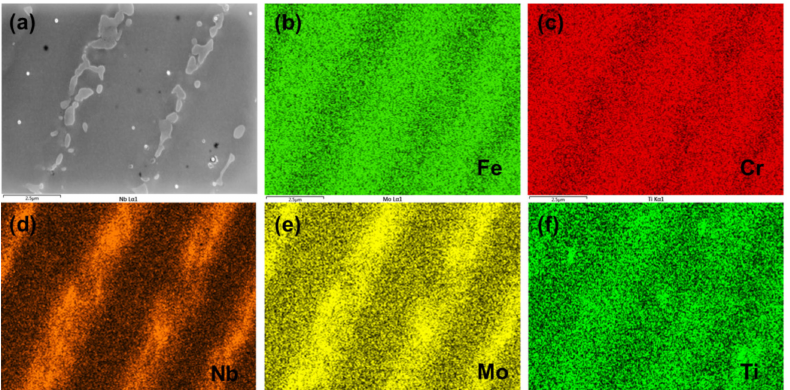
Figure 6. The typical SEM micrographs ( a ) and elemental distributions of as-fabricated sample: Fe ( b ), Cr ( c ), Nb ( d ), Mo ( e ) and Ti ( f ).